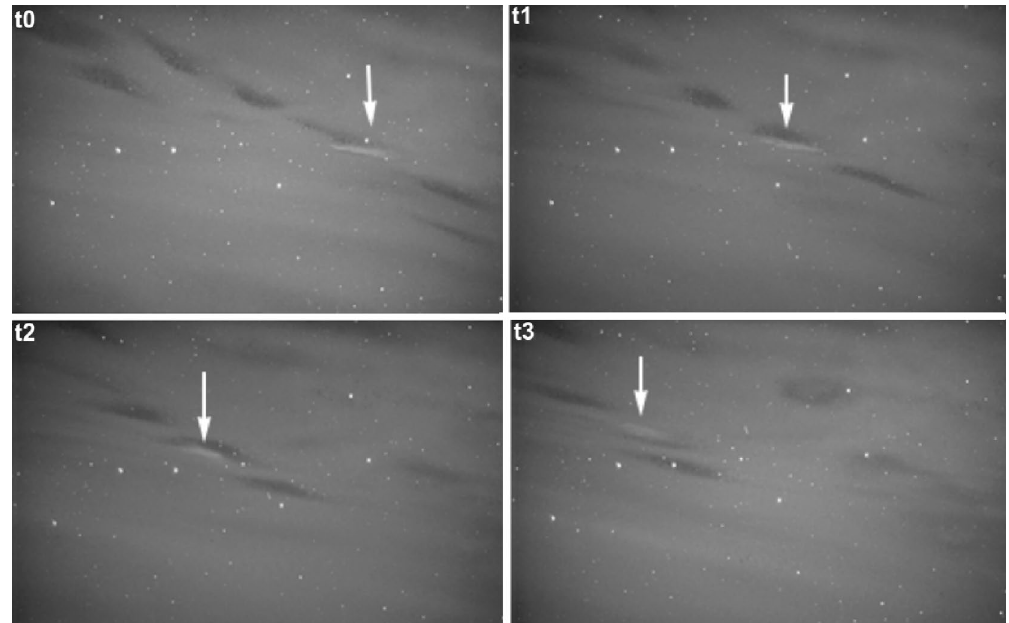
Figure 1. Time lapse white light images of the first anti-black aurora observed on 16 March 2007 from Tromsø, Norway, at about 21:30 UT. The greyscale or brightness range of the image is from black (dark) to white (bright). The frames have a ∼ 20 ◦ FOV based on the star field, and are in time steps of 1 s. North is up and East is left. (Dr. Torsten Aslaksen, Private communication). The white arrows highlight the black and anti-black aurora